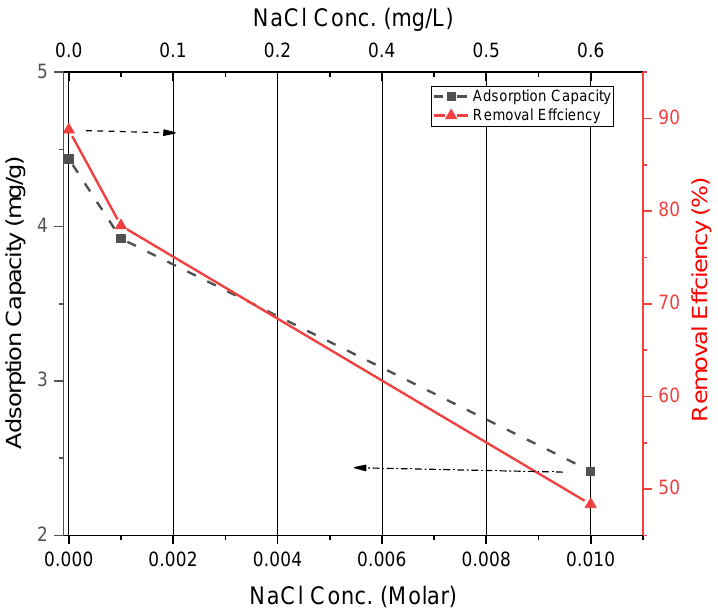
Figure 19. Mo removal efficiency and adsorption capacity of CDC at various NaCl concentrations in the feed solution.